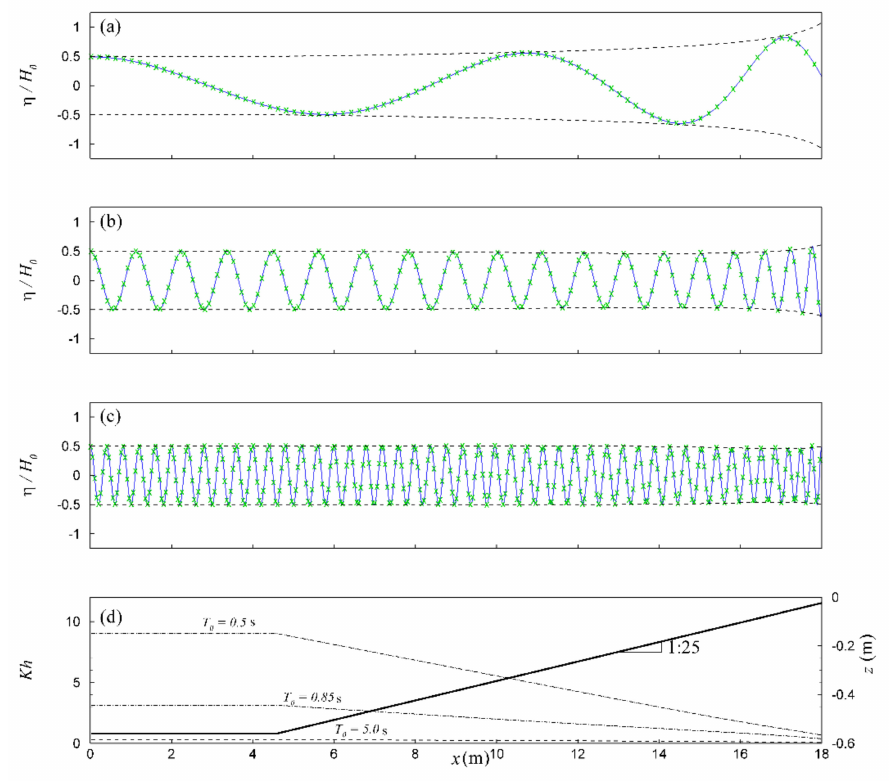
Figure 13. ( a – c ) The predicted spatial free-surface displacement for linear wave shoaling with Kh = 0.30, 3.13, and 9.0: wave envelope calculated by analytical solution (dashed lines), FNHS mode (solid lines), and QNHS mode (X marks). ( d ) The bottom configuration (bold solid lines) and the variation of Kh (dashed